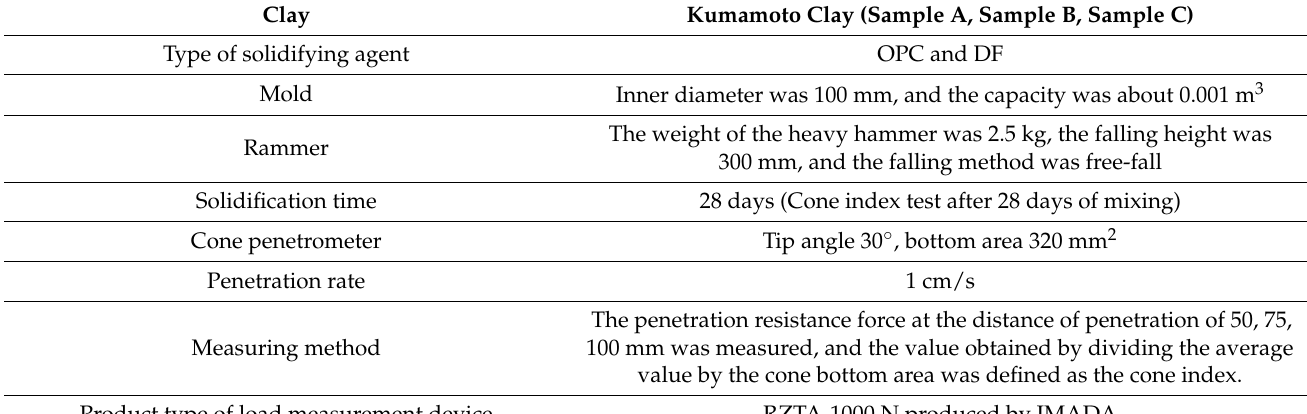
Table 2. Compaction and cone penetration test